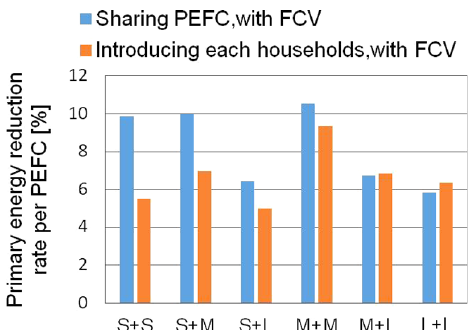
Fig. 12. Comparison of the case of sharing and introducing each other (based on the case without the PEFC system and with GV).